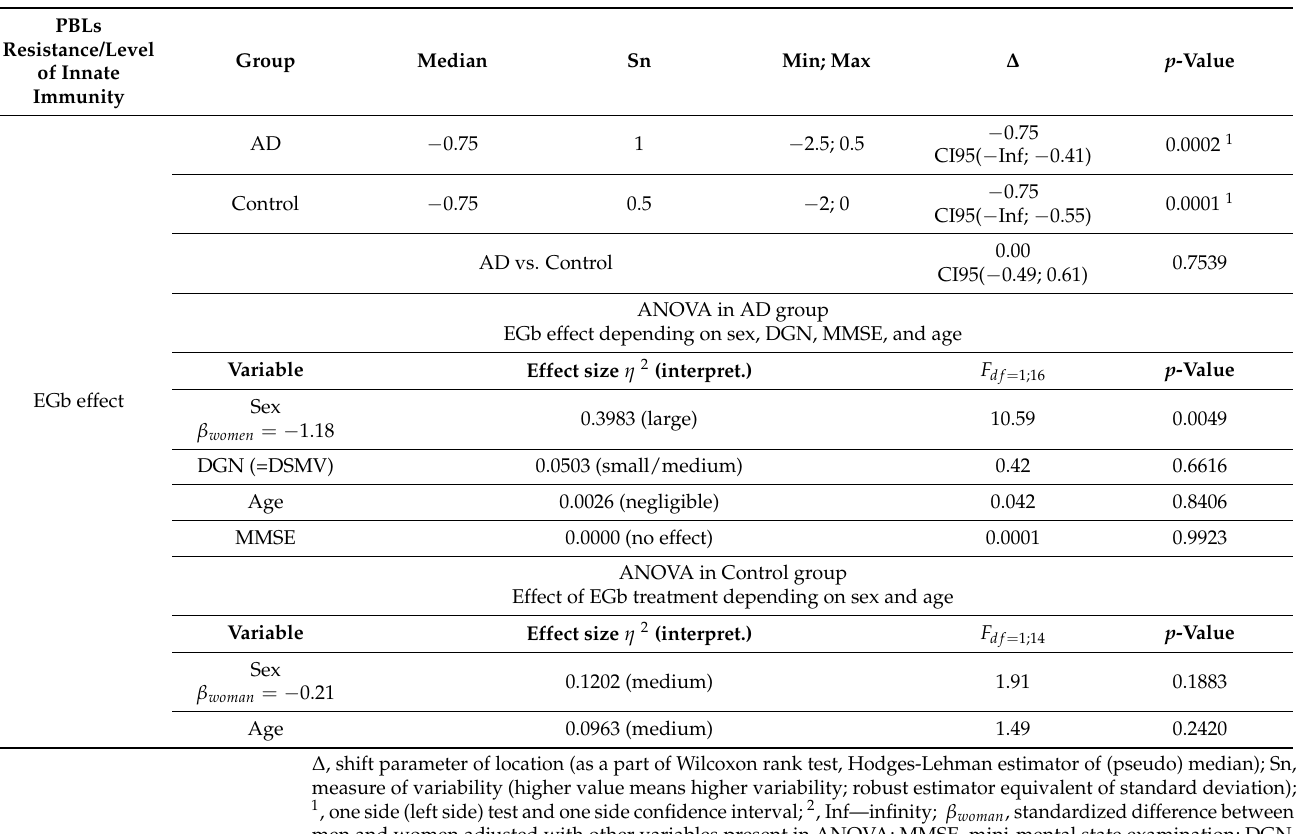
Table 4. Influence of EGb treatment on PBLs resistance/level of innate immunity in AD patients and healthy age-matched controls ( n =